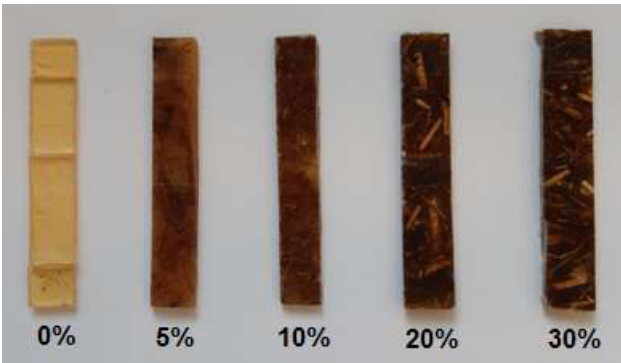
Figure 10. Photos of the studied samples after the DMA analysis.